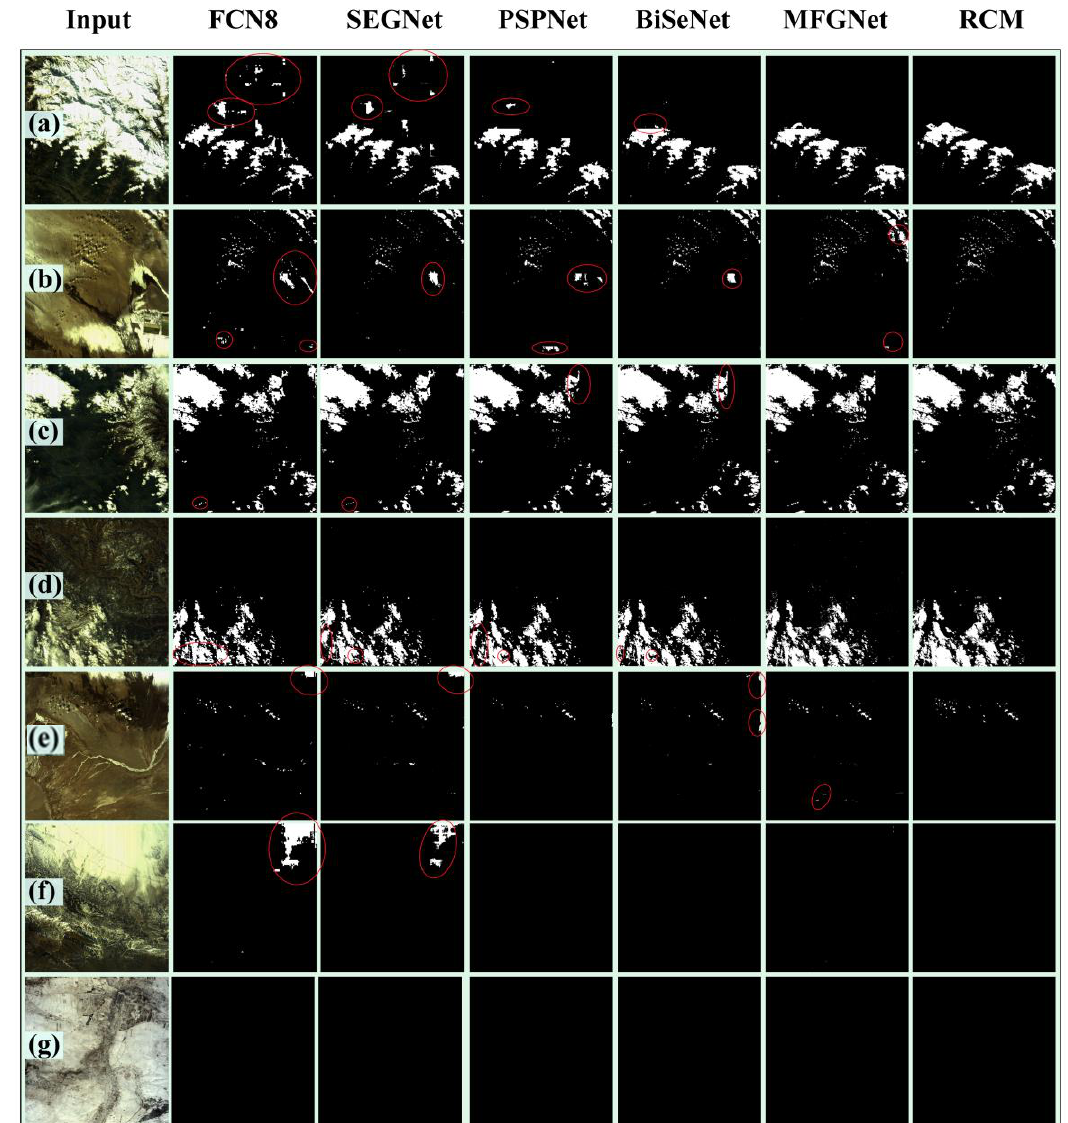
Figure 12. Comparison of cloud segmentation of CNN-based methods in the presence of cloud and snow. ( a – e ) are for cloud and snow coexisting cases, and ( f , g ) are for snow-only cases. All sizes of RGB images are 2008 ×